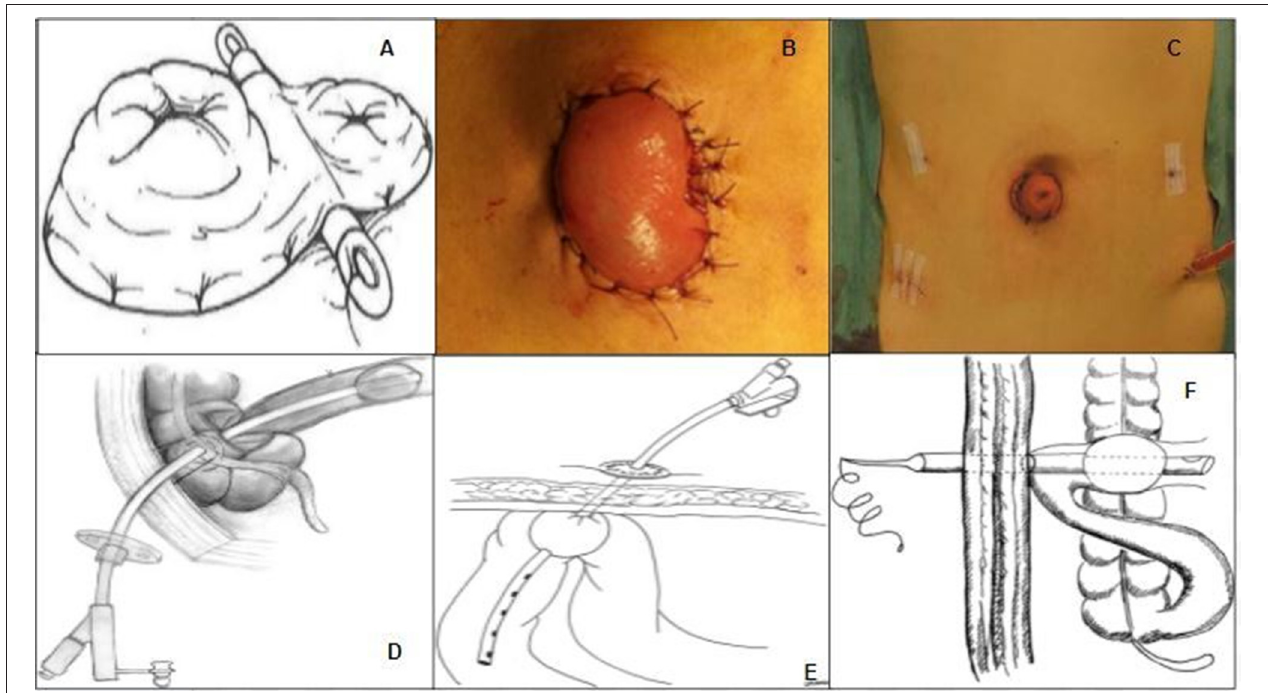
FIGURE 1 | (A) Classic Turnbull loop ileostomy, from Whitehead and Cataldo (11). (B) Skin bridge loop ileostomy, from Ye et al. (12). (C) Umbilical ileostomy, from Eto et al. (13). (D) Transcaecal ileostomy, from Monzòn-Abad et al. (14). (E) Percutaneous ileostomy, from Rondelli et al. (15). (F) Cannula ileostomy from Hua et al.